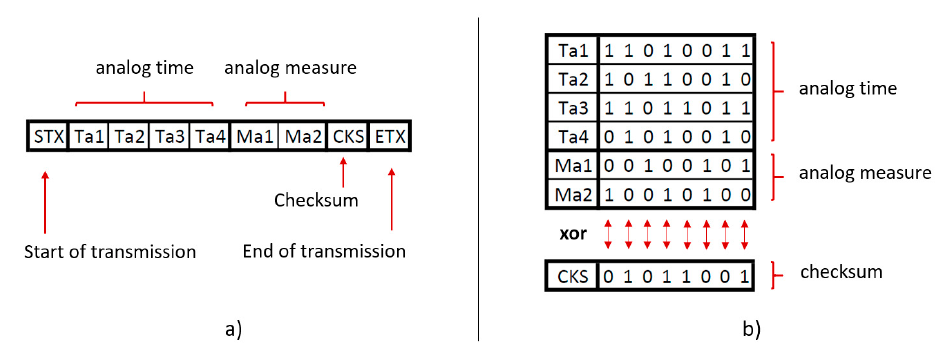
Figure 4. ( a ) Example of a string of bytes containing the data of an analog sensor along with a checksum byte and ( b ) numerical example of XOR checksum calculation.